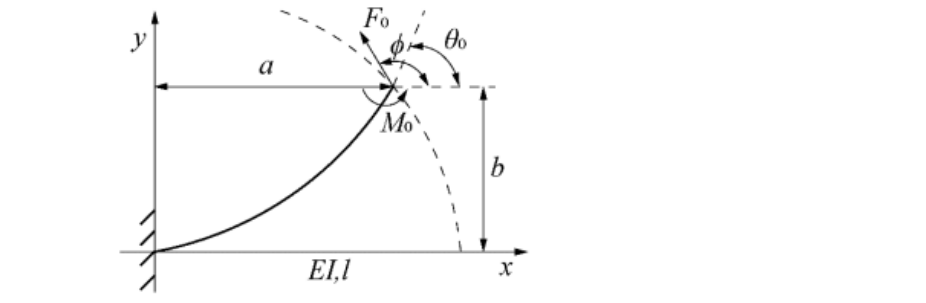
Figure 7. Shown is the deflection of a singular link on Meng’s design. Each joint can be modeled as a cantilever beam, and each initial position, torque, and angle can be adjusted accordingly.